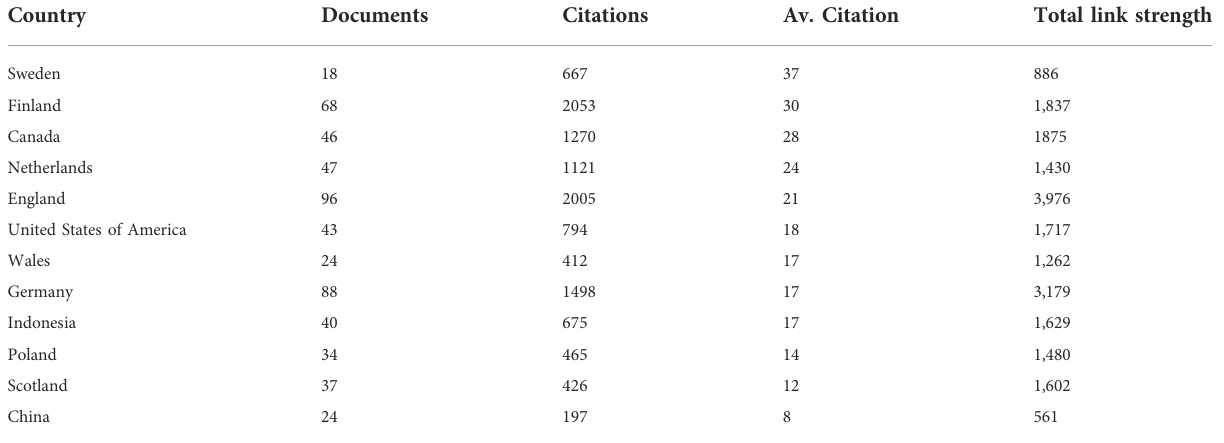
TABLE 5 Active countries in the restoration of degraded peatland